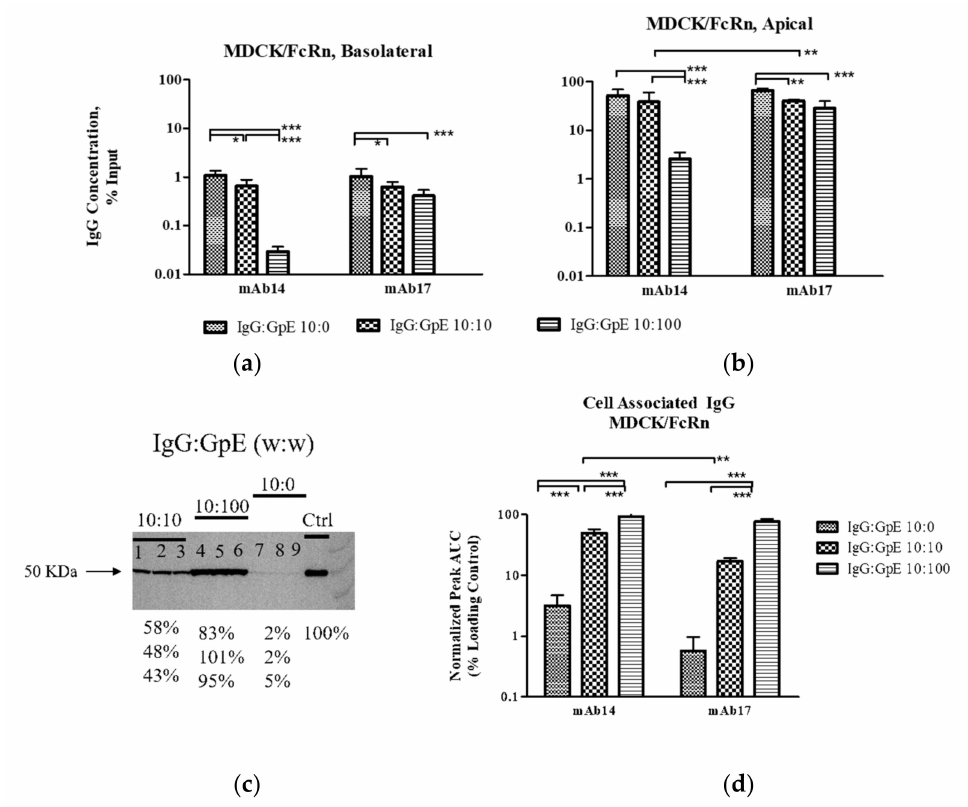
Figure 3. Transcytosis, internalization and degradation of IgG-gpE immune complexes (IC), assaying for IgG. IC were formed by mixing IgG and gpE at nominal w:w ratios of 10:0, 10:10 and 10:100 µ g/mL in the apical chamber of transwells containing monolayers of MDCK/FcRn or BeWo cells. Average data from three independent repeats are shown, error bars represent standard deviation. ( a ) Less transcytosis and ( b ) lower residual levels of IgG were seen with increasing amounts of antigen in the basolateral and apical chambers, respectively (data from experiments with MDCK/FcRn cells, analogous results were obtained from BeWo cells). ( c ) Representative western blot of the contents of the cell monolayer lysate; probing for IgG heavy chain. Each lane contains an independent repeat, three repeats for each IC are shown. ( d ) Quantification of band density using ImageJ shows cell retention of IgG increasing with increased gpE concentration. Signal intensities for each replicate are presented as a percentage of the positive control at the bottom of the western blot image. Uncropped image of the western blot is shown in the Supplemental Figure S1. * p < 0.05, ** p < 0.01, *** p <